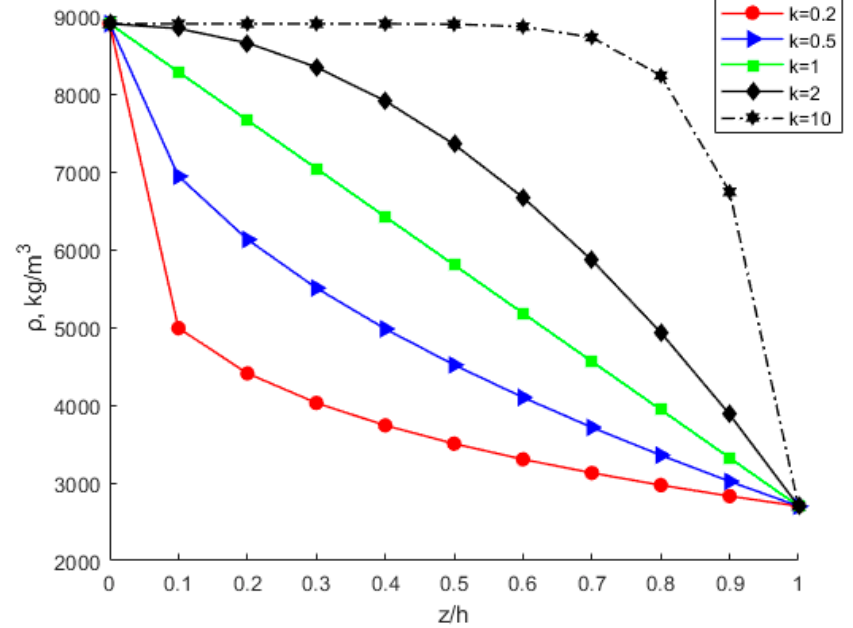
Figure 12. Variation in density through the thickness direction of the FGM plate.